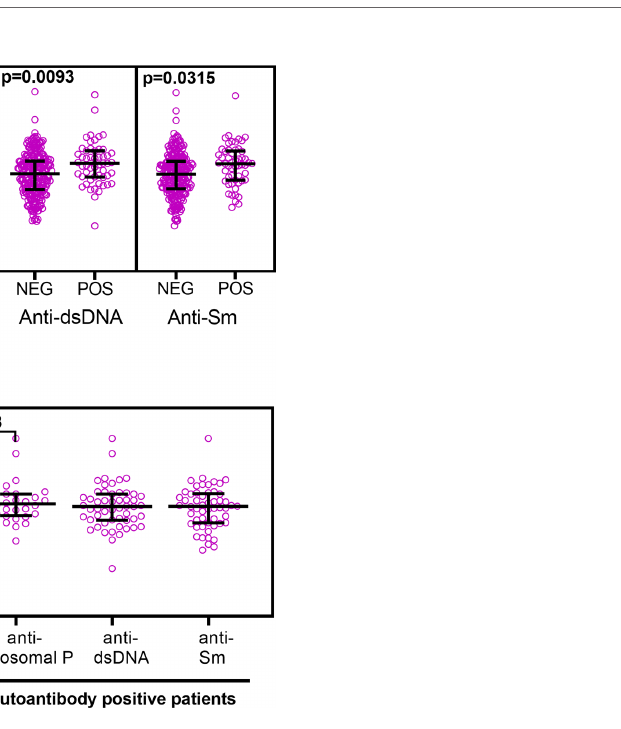
FIGURE 2 | Lupus patients positive for anti-Ribosomal P, anti-dsDNA, and anti-Sm show signi fi cantly higher anti- Eg IgG titers (A) . SLE patients were strati fi ed into autoantibody positive and autoantibody negative groups based on their reactivity to each antigen. The anti- Eg IgG titers were compared between the different groups using ANOVA, followed by Sidak ’ s multiple comparison ’ s post-test. The data from autoantibodies that failed to show signi fi cant association with anti- Eg IgG titers are shown in Supplementary Figure 2 . A comparison of anti- Eg IgG titers in healthy controls with patients positive for Ribosomal P, anti-dsDNA, and anti-Sm using ANOVA followed by Sidak ’ s multiple comparison post-test (B) . Adjusted p values < 0.05 reaching statistical signi fi cance are